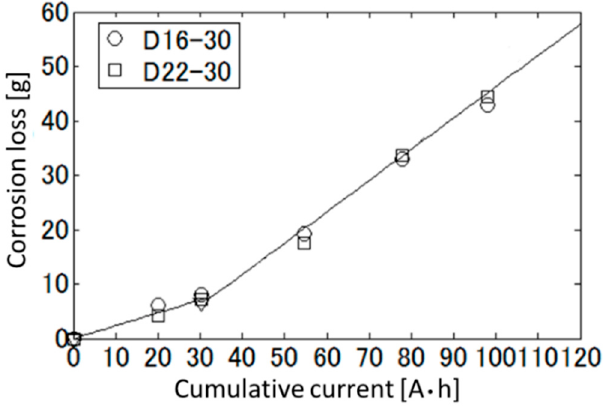
Figure 12. Relationship between the corrosion loss of the rebar and the cumulative current in the electrolytic corrosion test.